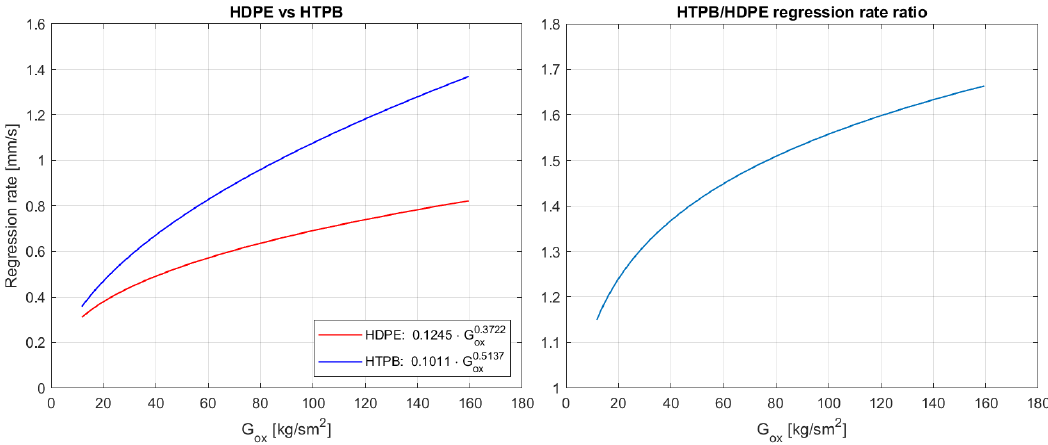
Figure 15. Comparison between HDPE and HTPB regression rates with varying G ox .